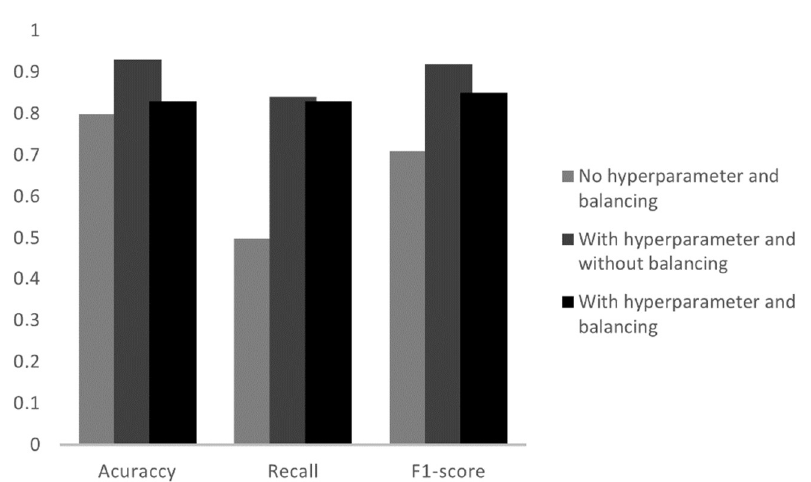
Figure 11. Analysis of the metrics of the three tests in the SVM model. Table 6. SVM parameters with hyperparameters and with unbalanced